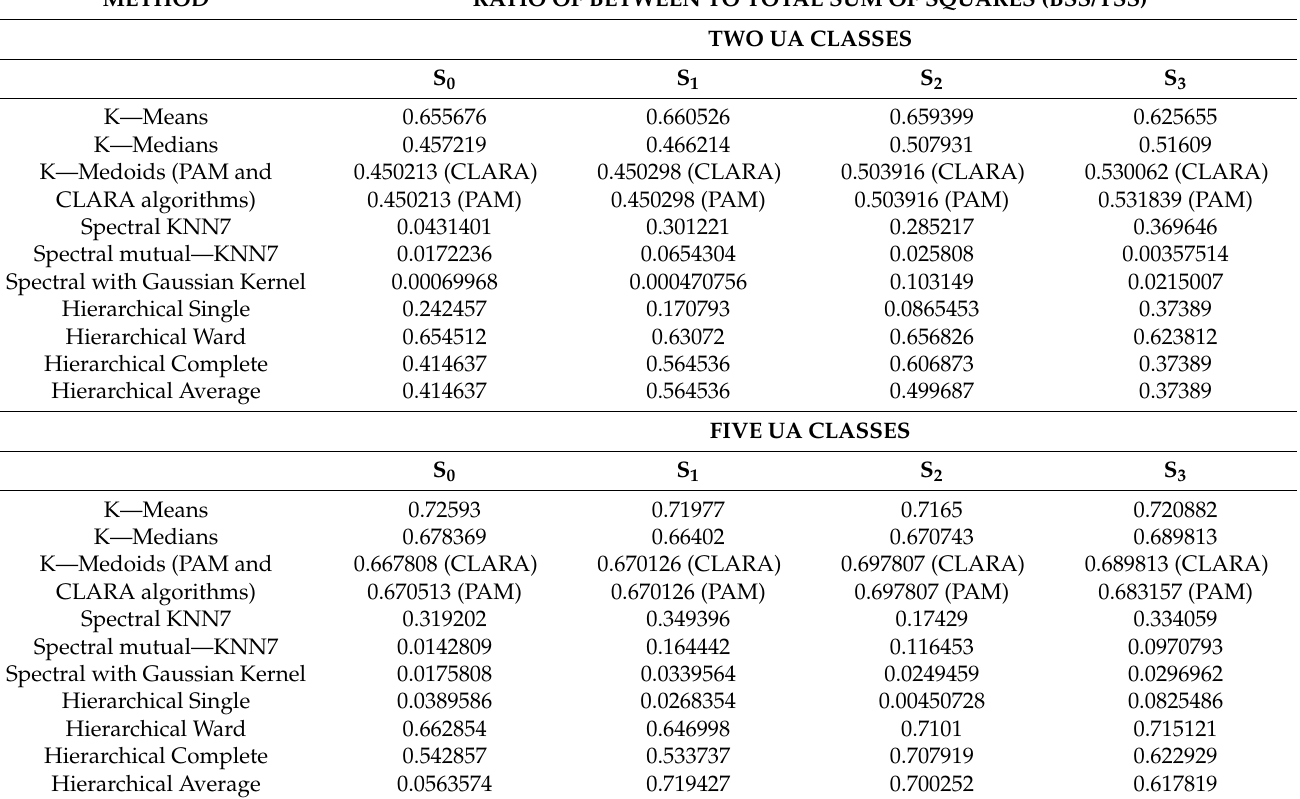
Table 3. BSS/TSS metric results of the cluster analysis considering, respectively, two and five Urban Atlas classes. K = 2. The better values for each method are